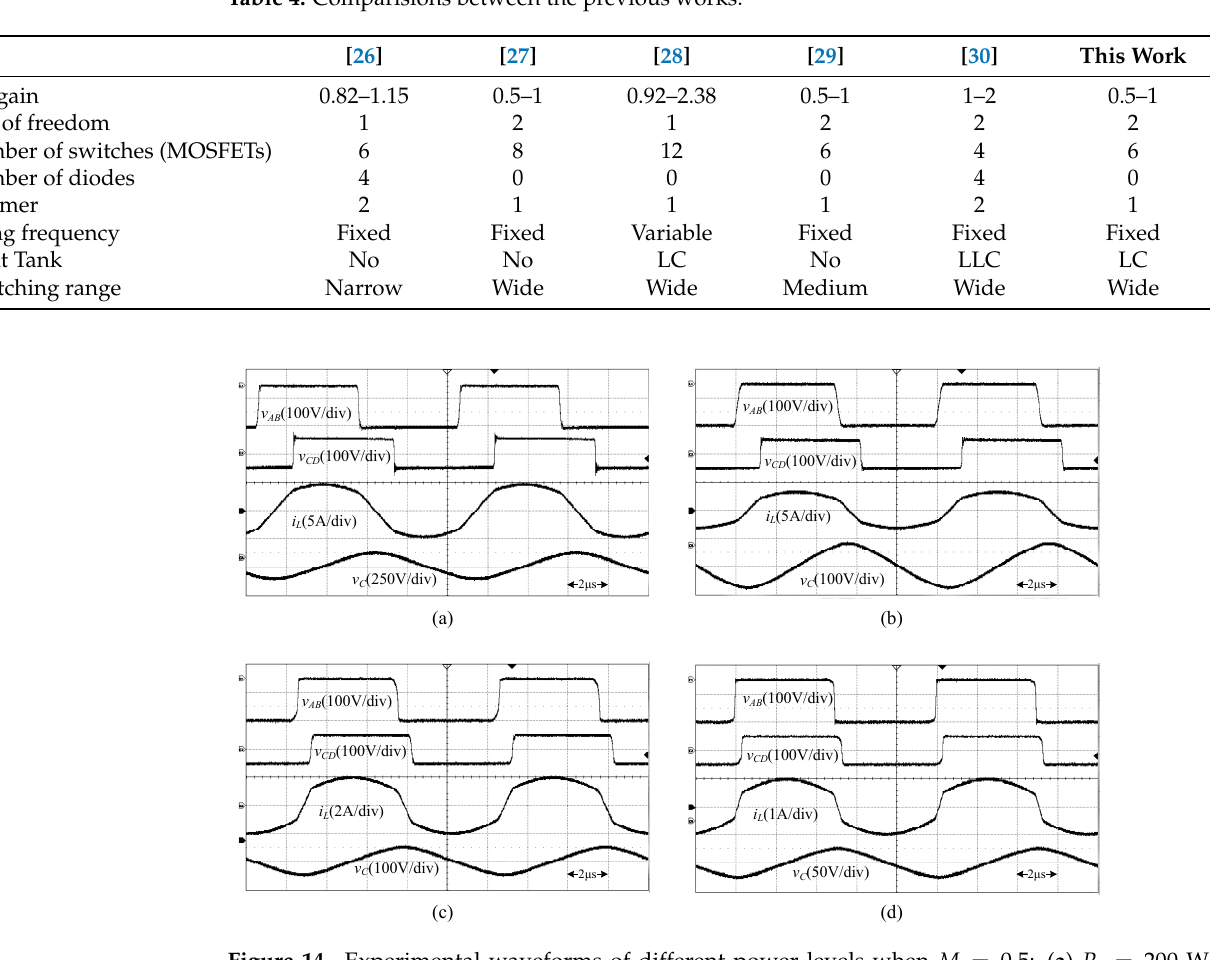
Figure 14. Experimental waveforms of different power levels when M = 0.5: ( a ) P o = 200 W, ( b ) P o = 150 W, ( c ) P o = 100 W, ( d ) P o = 50